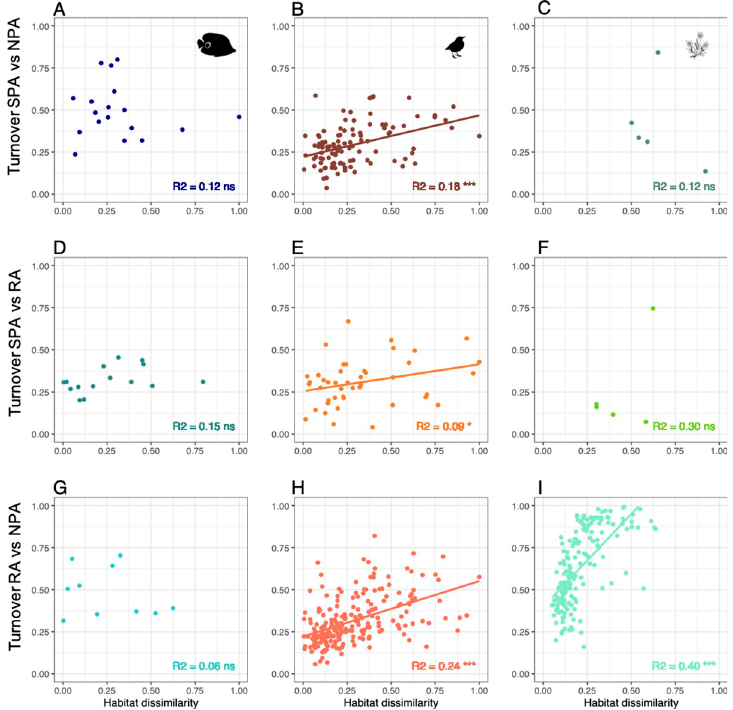
Fig 6. Linear relationships between environmental dissimilarity and species turnover for reef fishes ( A, D, G ), birds ( B, E, H ), and alpine plants ( C, F, I ). for pairwise comparisons between SPA, RA, and PA) across regions in a buffer of 50 km (each dot is a protected area). ��� p -value < 0.001, �� p -value < 0.01, � p -value < 0.05. The raw data can be found in https://github.com/LoiseauN/Betadiversity-protected-areas. NPA AU : AnabbreviationlisthasbeencompiledforthoseusedinFig 6 : Pleaseverifythatallentriesarecorrect : Inaddition ; pleasedefine � ns � inFig 6 abbreviationlistifthisindeedisanabbreviation : , Non-Protected Areas; ns, non significant; RA, Restricted Areas; SPA, Strictly Protected